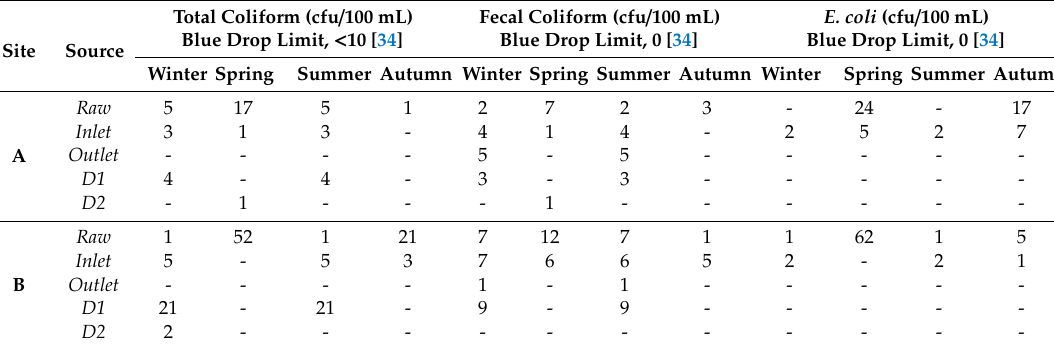
Table 2. Average number of indicator bacteria obtained during the sampling period.